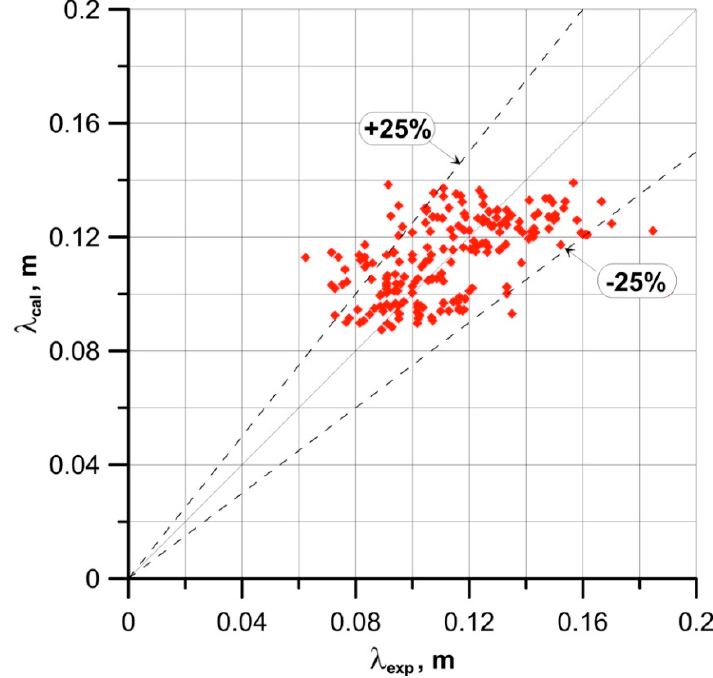
Figure 12. Comparison of measured and calculated values of wave length accompanying two-phase gas-very viscous liquid flow for relation (16).